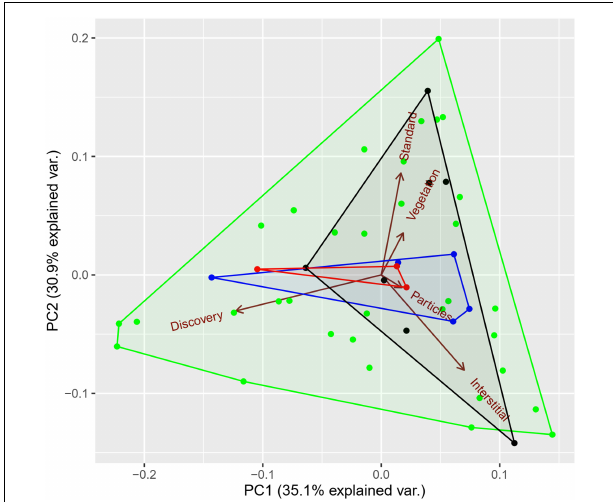
FIGURE 4 | Principal Component Analysis of the acquisition strategies niche space. The first and second axes represent the 35 and 31% of the variance, respectively. Dots and crosses correspond to forest and cropland species respectively distributed along resource axes. Convex hulls encompass four groups of species: in red and blue are dominant species in croplands and forests, respectively. In black and green are the remaining species for croplands and forests. The abbreviations correspond to acquisition strategies as follows: Standard, standard reference bait; Interstitial, litter-surrounded bait; Vegetation, baits placed on vegetation; Particles, small amounts; Discovery, rapid exploitation.